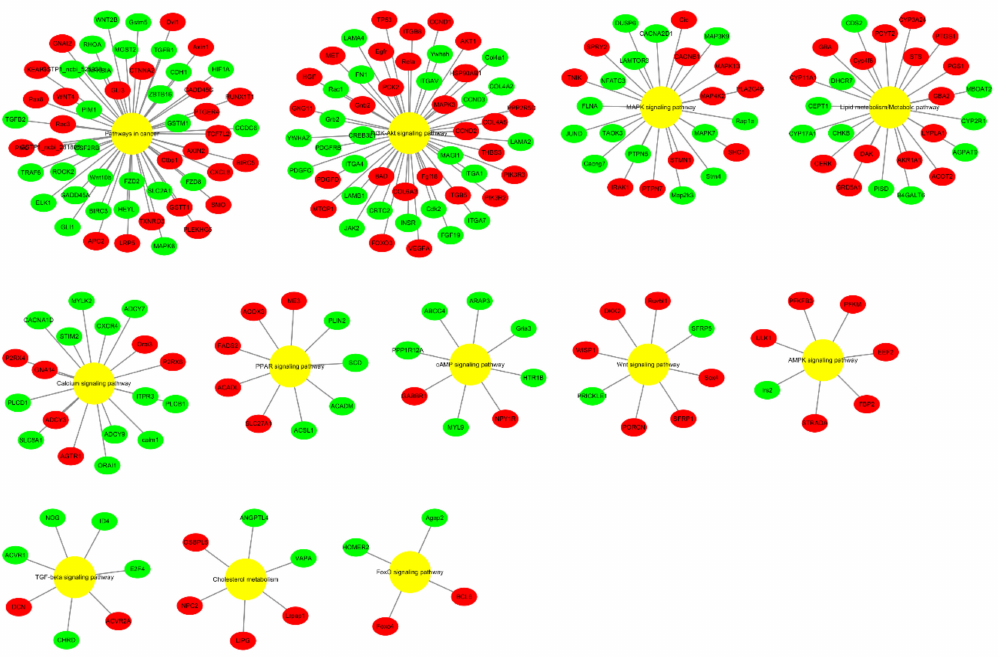
Figure 9. The distribution of up- and downregulated DEG enrichment in different KEGG (Kyoto Encyclopedia of Genes and Genomes) pathways. The pathway nodes are represented by pathways (yellow), downregulated genes (green), and upregulated genes (red), which are shown as